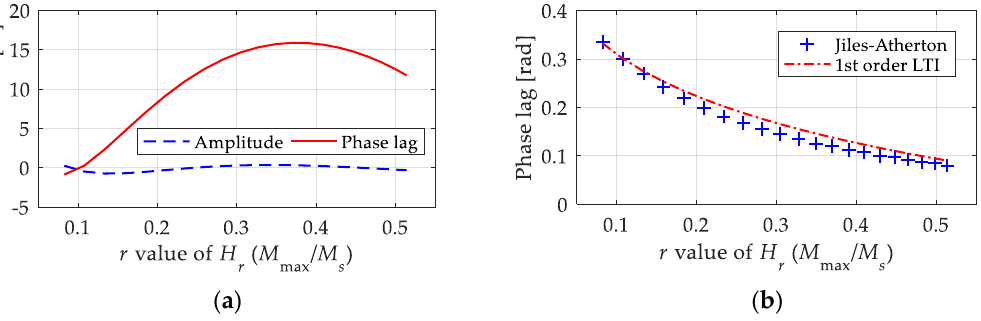
Figure 10. Relative errors of the 1st LTI system model in calculating the amplitude and equivalent phase lag under fixed parameters ( k = 2 kA/m, a = 12 kA/m, c = 0.2, α = − 0.001 and M S = 80 kA/m): ( a ) relative errors; ( b ) absolute value of equivalent phase lag.